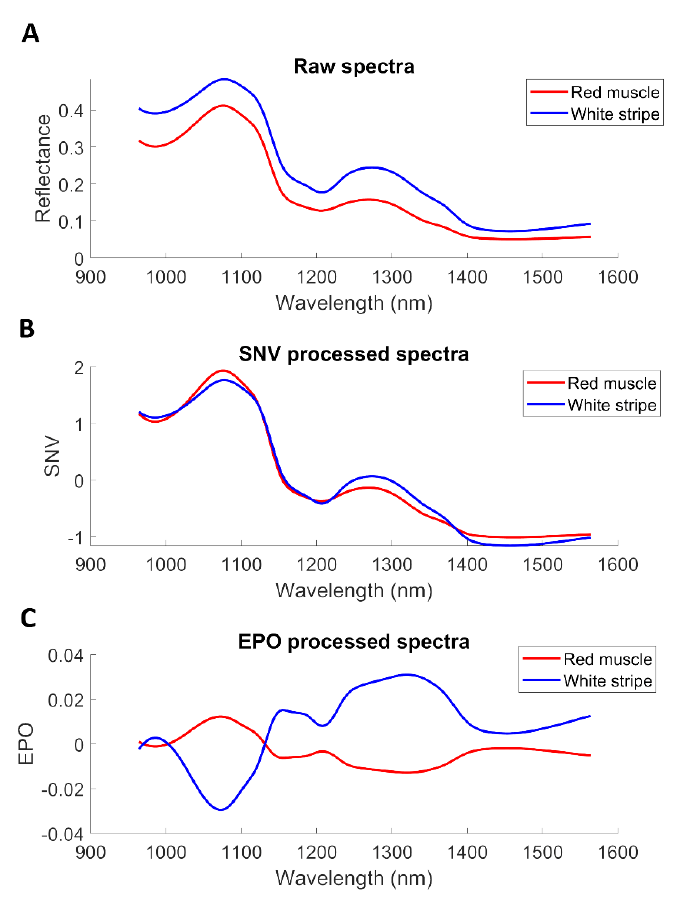
Figure 7. Influence of different spectral pre ‐ processing methods on the mean spectra of one hypercube in the training set. ( A ) Raw spectra; ( B ) Pre ‐ processed spectra with SNV; ( C ) Pre ‐ processed spectra with